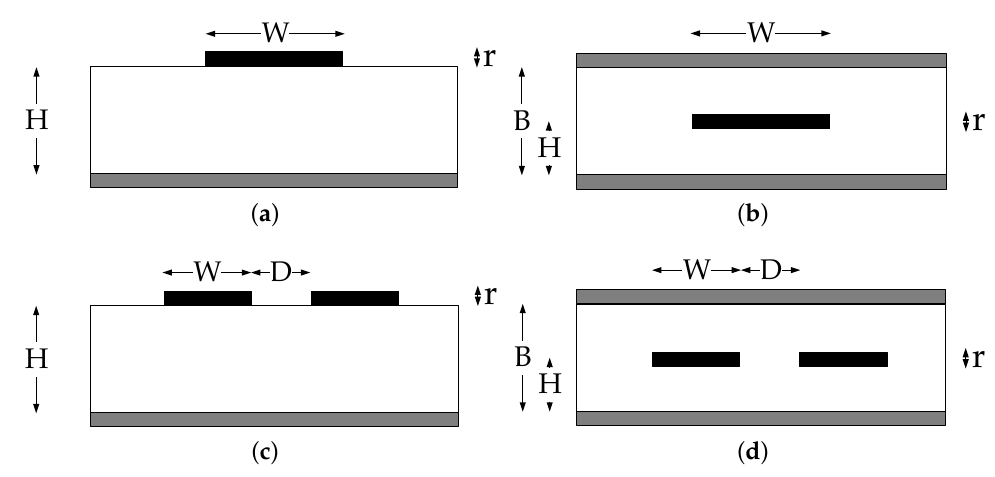
Figure 4. The 4 waveguides used in the IRIS platform design: ( a ) Microstrip; ( b ) Stripline; ( c ) Differential microstrip; ( d ) Differential